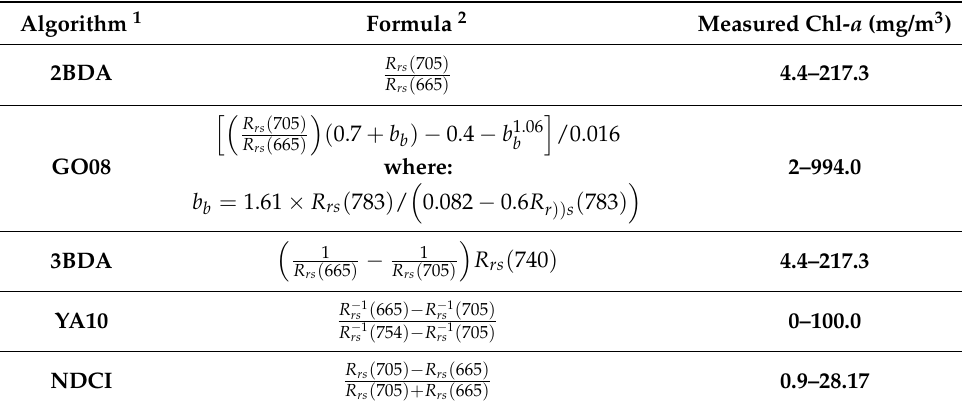
Table 2. List of the bio-optical algorithms for chl- a used in this study.